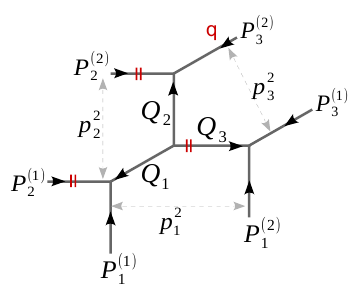
Figure 2 . The 5-brane web diagram for T 2 with the choice of the preferred direction and the K(cid:127)ahler parameters. The edges along the preferred direction are marked by two red